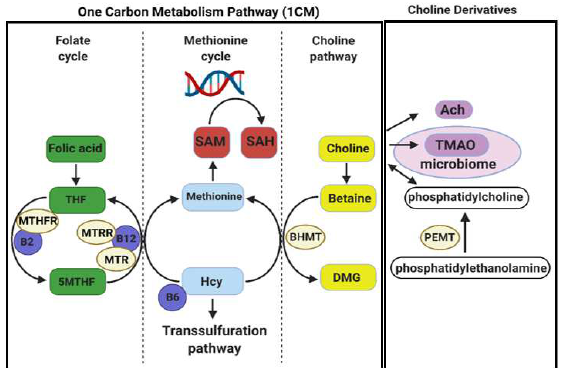
Figure 1. Illustration of the one-carbon metabolism (1CM) pathway and choline derivatives. The 1CM pathway is divided into the folate cycle, methionine cycle, and the choline pathway. The choline derivatives acetylcholine (Ach) and trimethylamine oxide (TMAO), and the endogenous choline syn- thesis pathway, catalyzed by phosphatidylethanolamine methyltransferase (PEMT), are also shown. THF = tetrahydrofolate; 5MTHF = 5-methyl-tetrahydrofolate; MTHFR = methylenetetrahydrofolate reduc- tase; MTR = methionine synthase; MTRR = methionine synthase reductase; SAM = s-adenosylmethionine; SAH = s-adenosylhomocysteine; Hcy = homocysteine; DMG = dimethylglycine; BHMT = betaine homo- cysteine